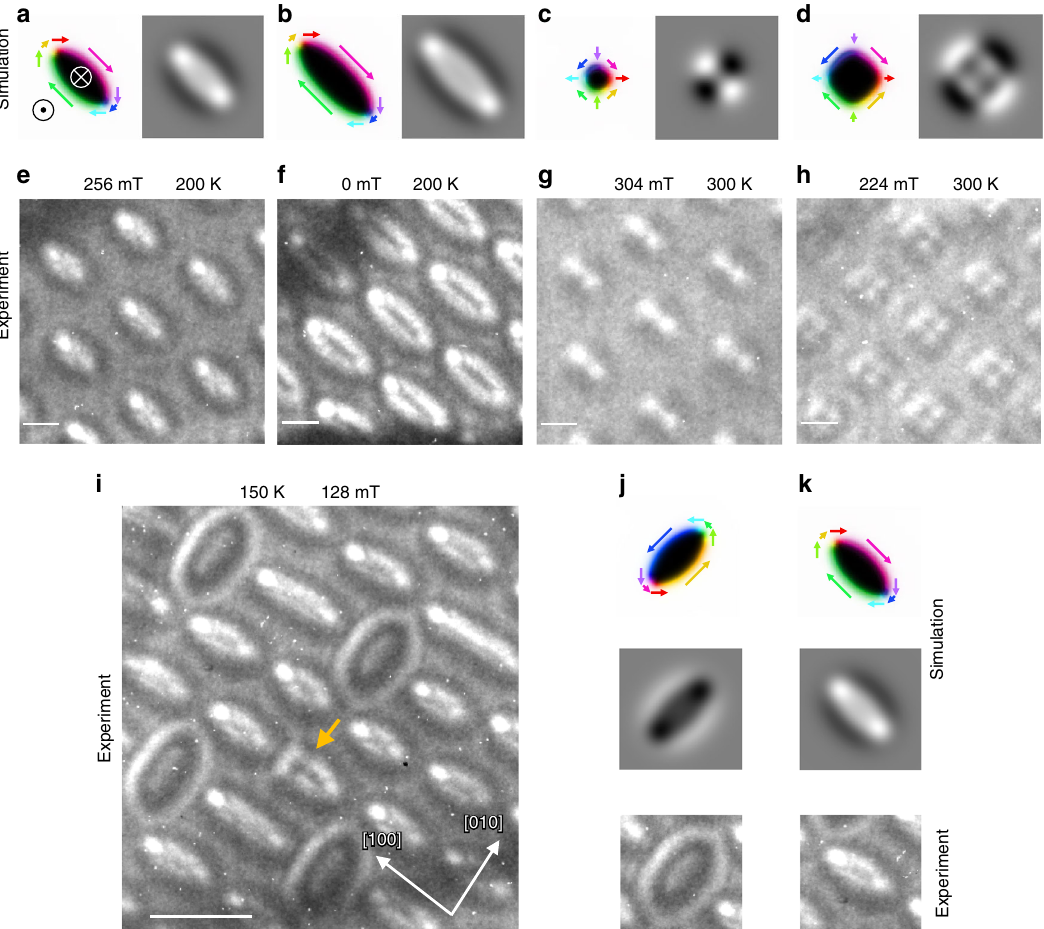
Fig. 5 Micromagnetic simulations of elliptical skyrmions and antiskyrmions. In a – d different magnetic textures are stabilized starting from a skyrmion or an antiskyrmion. The resulting textures are elongated skyrmions in a , b , a round antiskyrmion in c , and a square-shaped antiskyrmion in d . In a , b we started from a Bloch skyrmion con fi guration and in c , d from an antiskyrmion. The out-of-plane magnetic fi elds in the simulations are: a 180mT, b 170mT, c 210mT, and d 180 mT. The calculated LTEM images (right panels) are in good agreement with the experimentally observed patterns ( e – h ). The magni fi ed images in e – h are taken from Fig. 3b (256 mT, 200 K), 3e (0 mT, 200 K), 1h (304 mT, 300 K), and 1j (224 mT, 300 K), respectively. A comparison of the experimentally observed lattices of round and square antiskyrmions, as well as elliptical skyrmions, is shown in Supplementary Fig. 6. The scale bars for the LTEM images in e – h correspond to 100 nm. In i – k the coexistence of elliptical skyrmions with opposite chiralities is shown at 150 K and 128 mT. Micromagnetic simulations of the two objects ( j , k ) con fi rm this interpretation. Furthermore, a topologically trivial object is highlighted by the orange arrow. Here, the scale bars correspond to 300